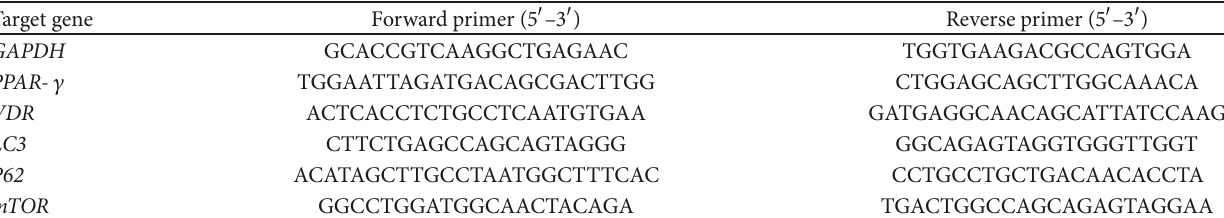
Table 1: Sequences of